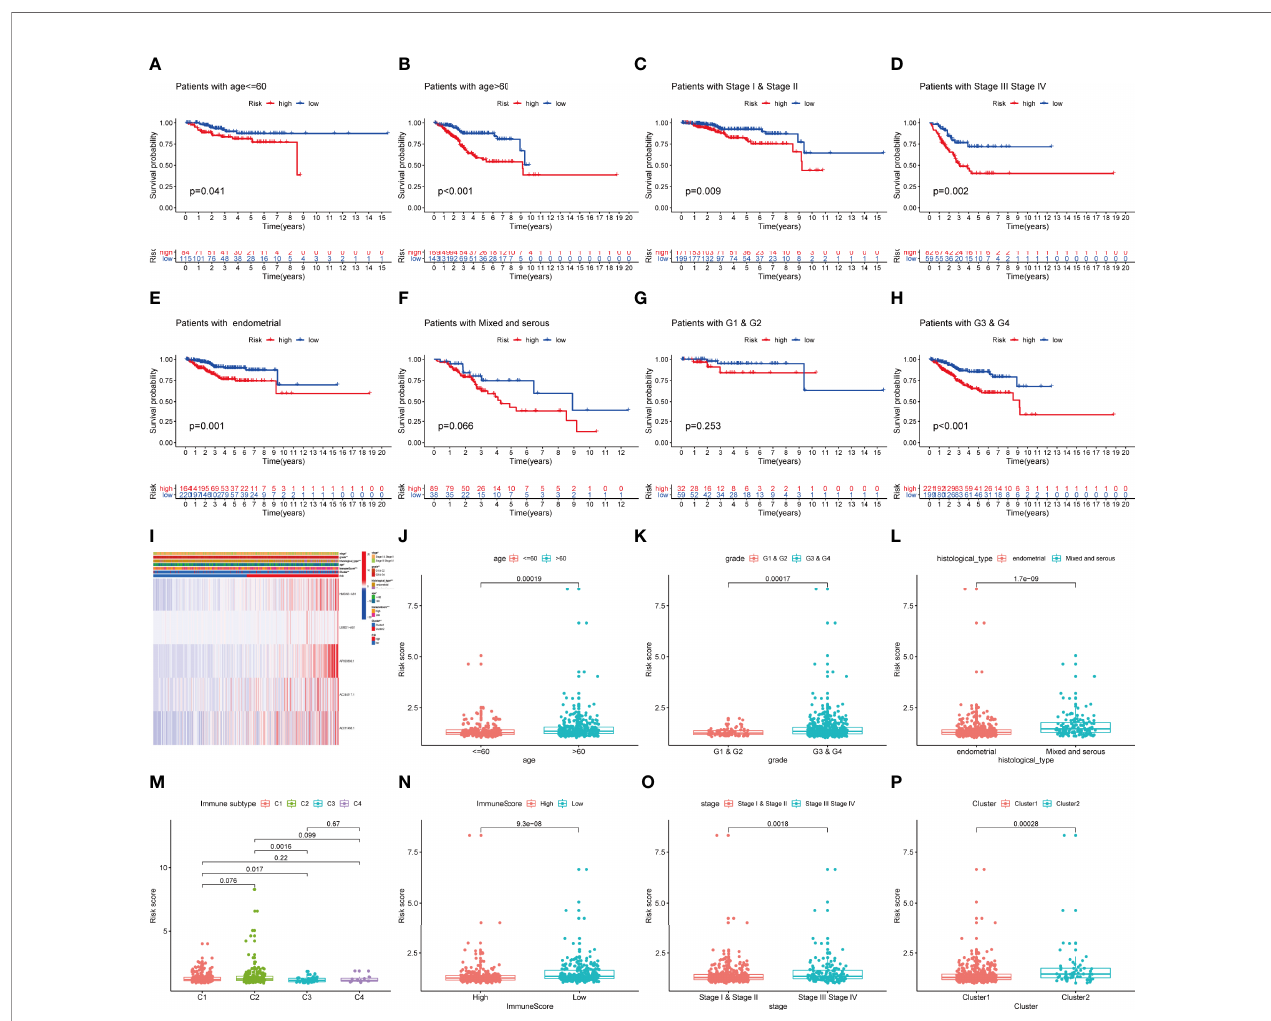
FIGURE 5 | The prognostic value of IRLPS in strati fi ed patient groups, and correlation of IRLPS with clinicopathological features and immunescore. IRLPS showed satisfactory prediction performance in patients regardless of (A, B) age and (C, D) stage, (E, F) histological type and (G, H) grade. (I) Heatmap and clinical features of the groups. (J – P) Distribution of IRLPS strati fi ed by (J) age, (K) grade, (L) histological type, (N) immunological subtype, (M) Immunescore, (O) tumor stage and (P) cluster. *P < 0.05, **P < 0.01 ***P <